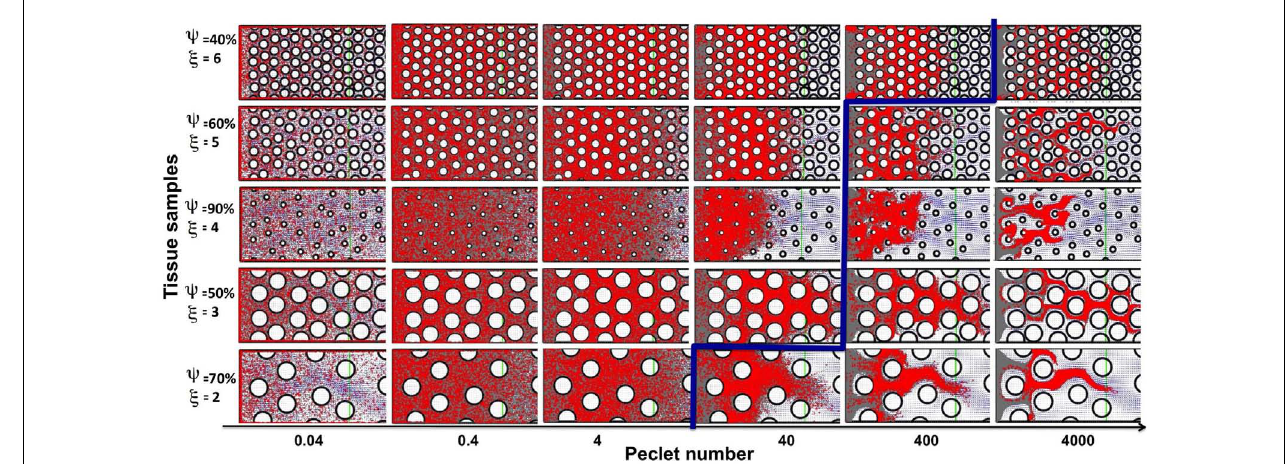
( Pe = 0.04–4) the transport is diffusion-dominated for all tissue topologies. For the maximal considered Péclet number ( Pe = 4000) the transport is convection-driven for all tissue architectures. In the case of the medium Péclet numbers ( Pe = 40–400) the particle transport changes its characteristics depending on the tissue